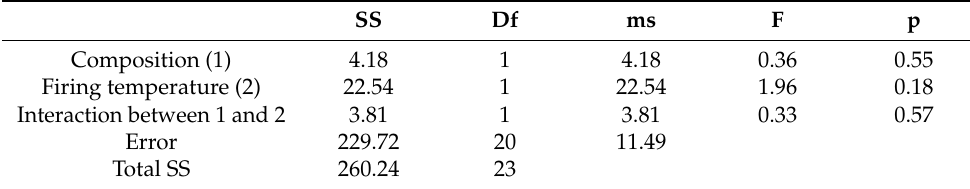
Table 8. Analysis of the porosity values variance for the studied